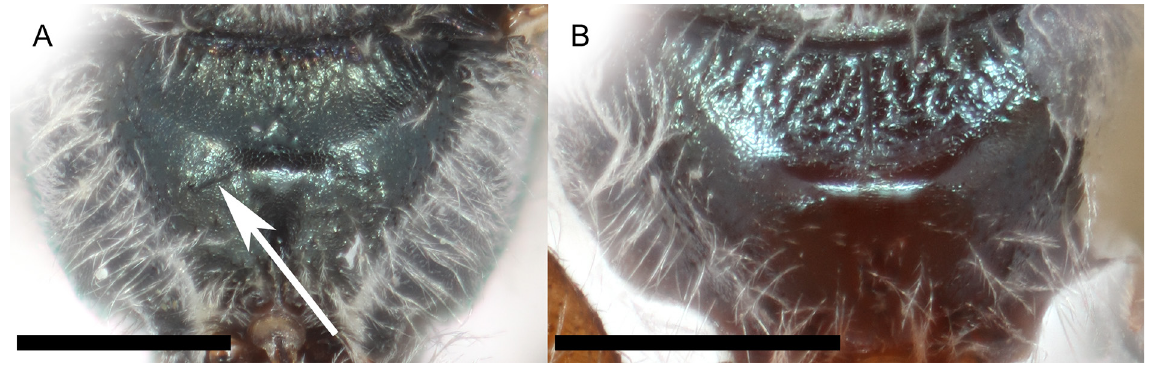
Fig. 98. Propodeum. A . Lasioglossum ( D. ) testaceum (Robertson, 1897), ♀, with strong oblique carina (arrow). B . L. ( D. ) minckleyi sp. nov., ♀, without oblique carina. Scale bars: 0.5